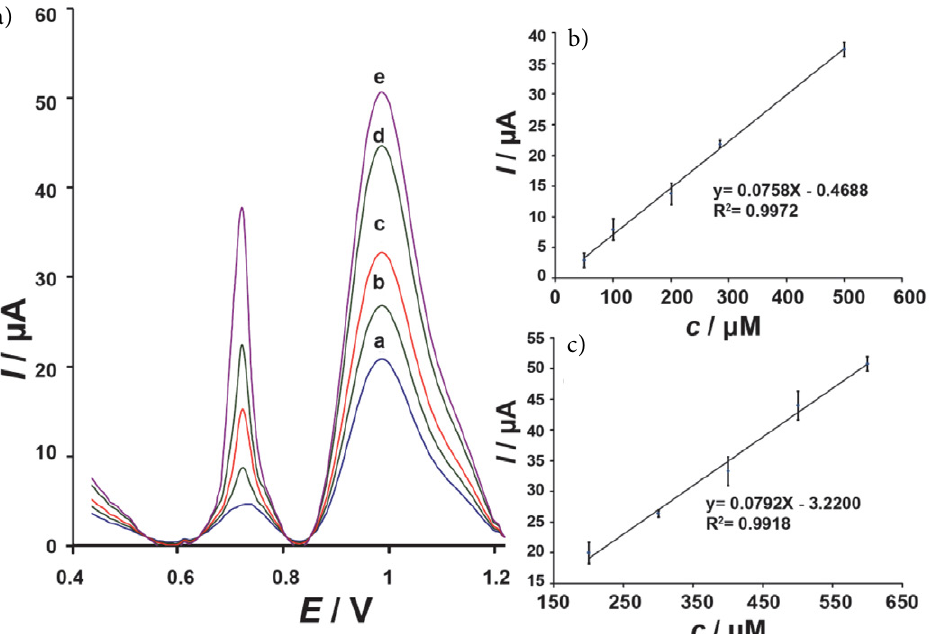
Figure 6. Inset; SWVs of CuO/1E3MIBF 4 /CPE ( PBS buffer, pH 7.0) containing different concentrations of 6-TG and 5-FU in μmol L −1 . (a–e) 50 + 200; 100 + 300; 200 + 400; 285 + 500 and 500 + 600, respectively. B) plot of the current as a function of 6-TG concentration. C) plot of the current as a function of 5-FU